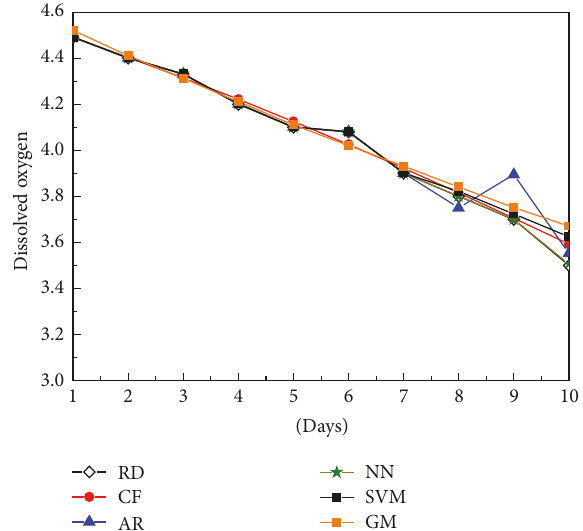
Figure 1: The actual value and predicted value for the first pond.